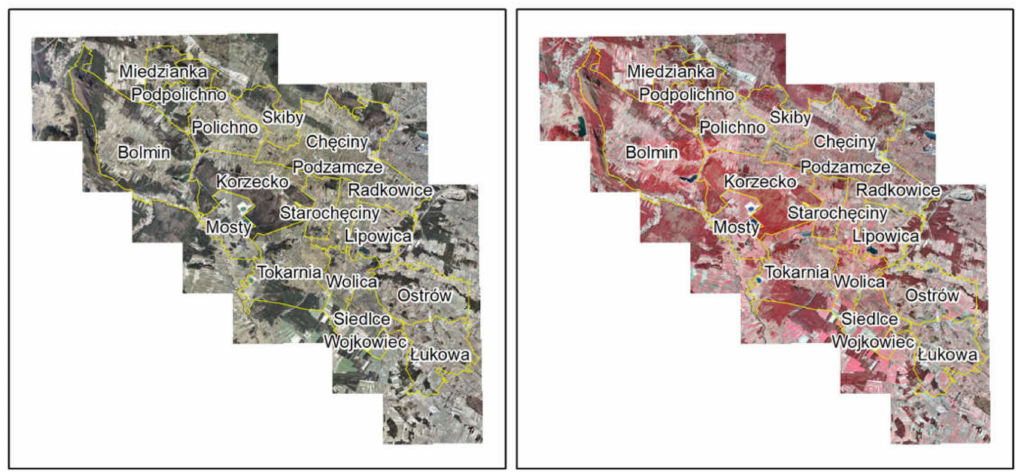
Figure 2. RGB and CIR compositions